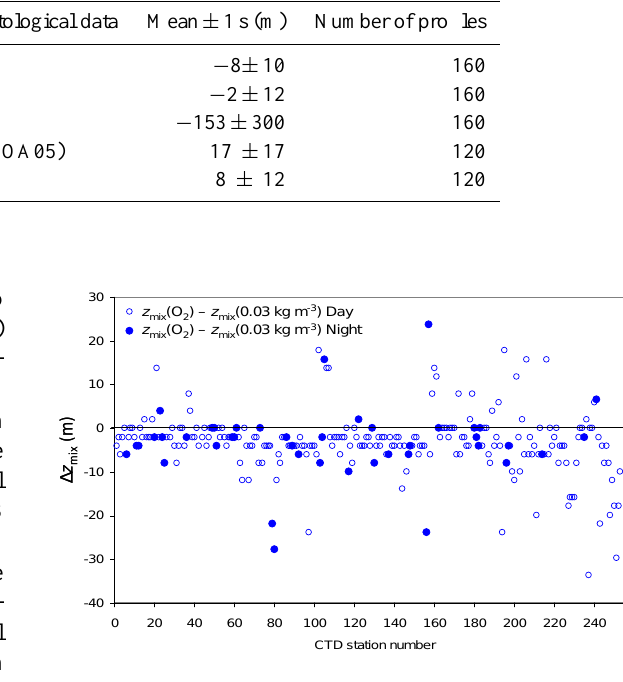
Fig. 6. Difference between z mix (O 2 ) and z mix (0.03kgm − 3 ) during day and